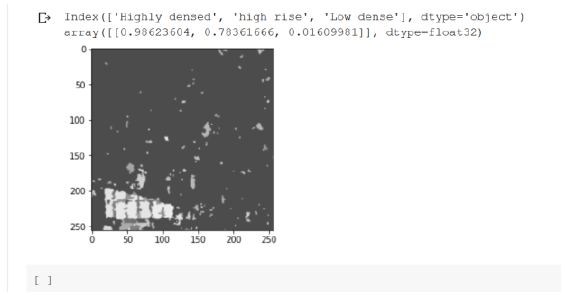
Figure 24 . Result of 256 X 256 Amplitude Image.